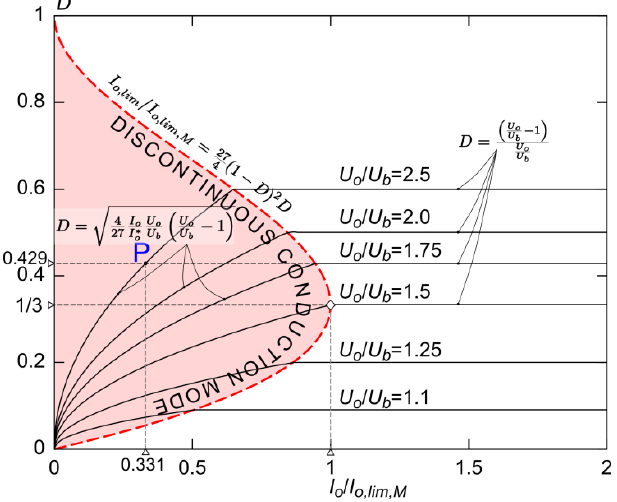
Figure 8. Layout 1 discharge operation: D as a function of current I o / I o,lim,M for different U o / U b values.